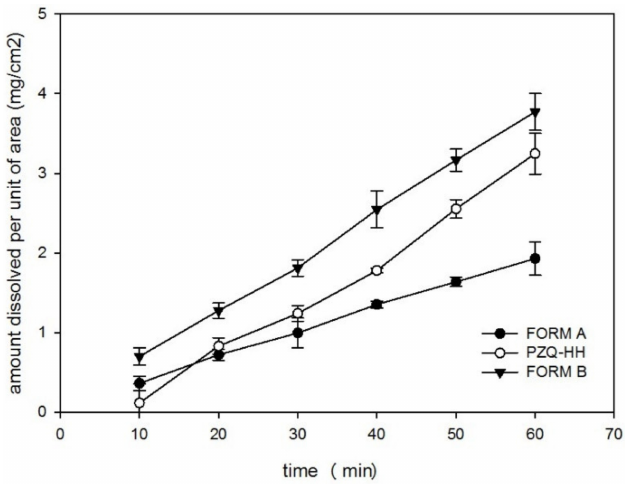
Figure 10. Intrinsic dissolution rate profiles in water at 37 ◦ C for PZQ-HH, Form B and Form